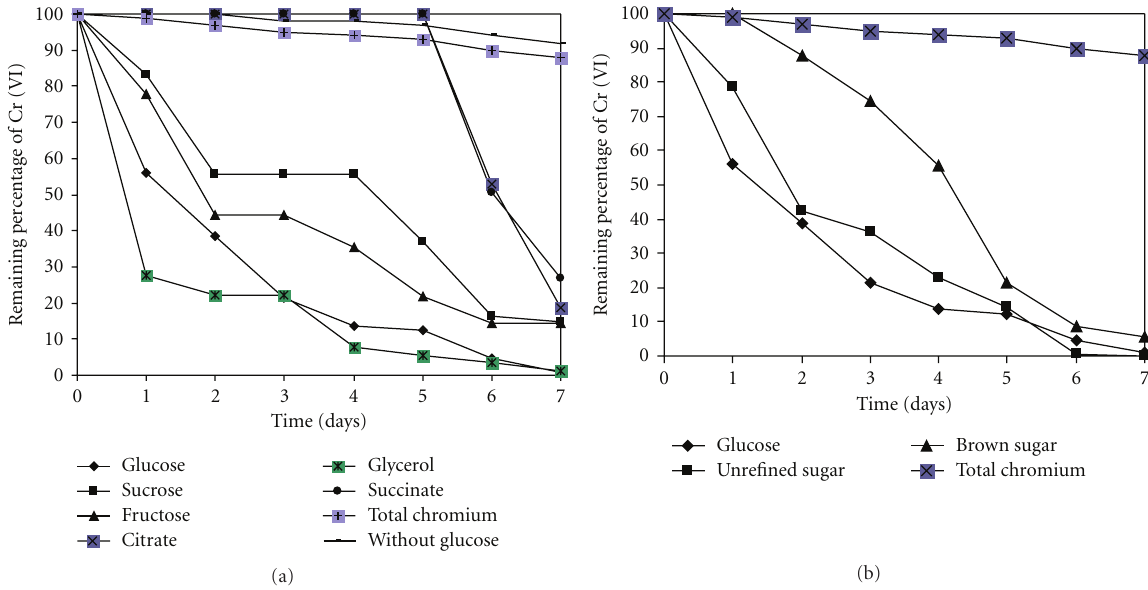
Figure 5: Influence of carbon source on the capability of Paecilomyces sp. to decrease Cr (VI) levels in the growth medium. 100 rpm, 28 ◦ C, pH 4.0. Influence of commercial carbon sources and salt on the capability of Paecilomyces sp. to decrease Cr (VI) levels in the growth medium. 100rpm, 28 ◦ C, pH 4.0.